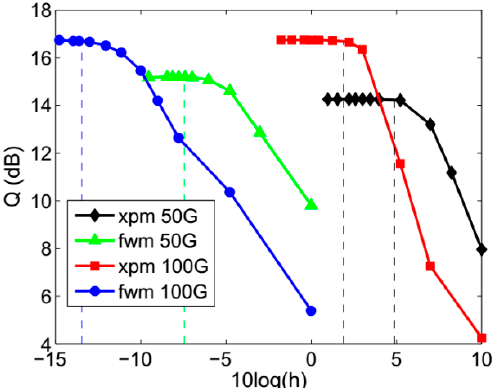
Figure 10. Q factor and step size for XPM and FWM compensation within the 50 GHz and 100 GHz